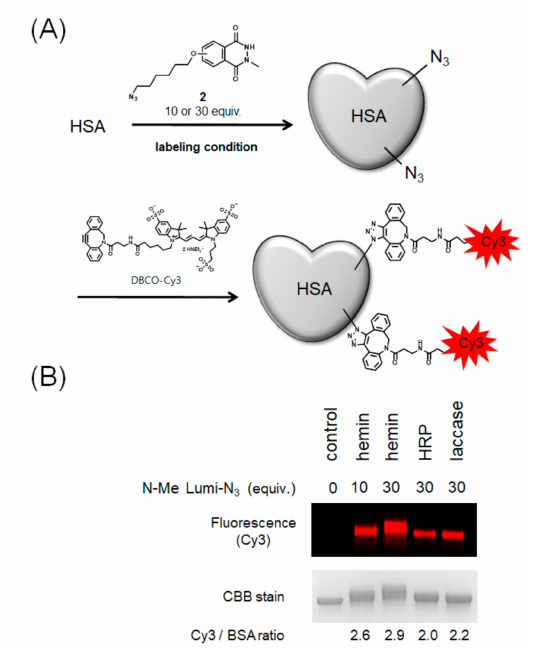
Figure 5. Modification of HSA with azide-conjugated N -methylated luminol derivative ( 2 ) and comparison of modification efficiencies. ( A ) Scheme of HSA modification using 2 and DBCO-Cy3. ( B ) Comparison of modification efficiency from Cy3 fluorescence intensity. N = 2. Representative fluorescent gel is shown in Figure